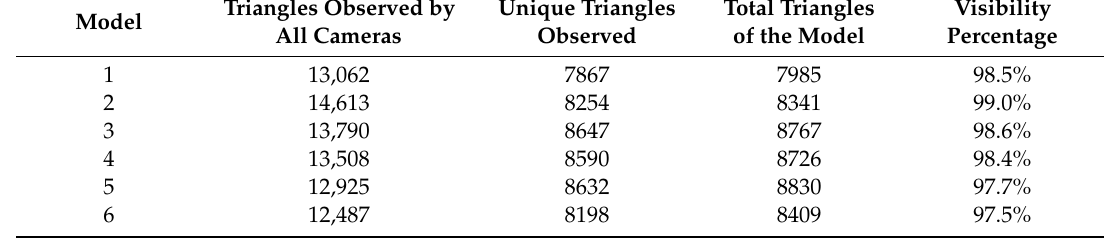
Table 9. Visibility results: triangles observed by all cameras, across each model. Both unique and total triangles observed are provided.